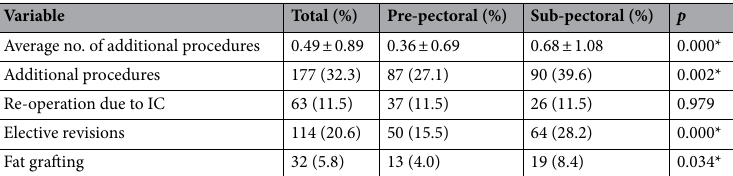
Table 4. Revision procedure data. This table analyzes follow-up procedure data of both the pre-pectoral implant cohort and the sub-pectoral implant cohort. The average number and frequency of additional procedures significantly differs between the sub-pectoral and the pre-pectoral groups. Additionally, the sub-pectoral cohort was found to have a higher incidence of elective procedures. Continuous variables were analyzed via independent two-tailed t-tests (95% confidence interval) and displayed with standard deviation values. Non-continuous variables were analyzed via Pearson’s chi square. ± SD; 95% CI. First row values are an average of revisions across all patients in each group. (e.g., 0.36 revision procedures per patient undergoing pre-pectoral reconstruction). Additional Procedures: percentage patients per cohort that underwent subsequent procedure either for acute complication or elective revision. IC, immediate complication; includes seroma, hematoma, skin flap necrosis, infection, and explantation. Elective revisions include fat grafting, capsule procedures, symmetry procedures, and implant exchange. *Statistically significant ( p < 0.05).